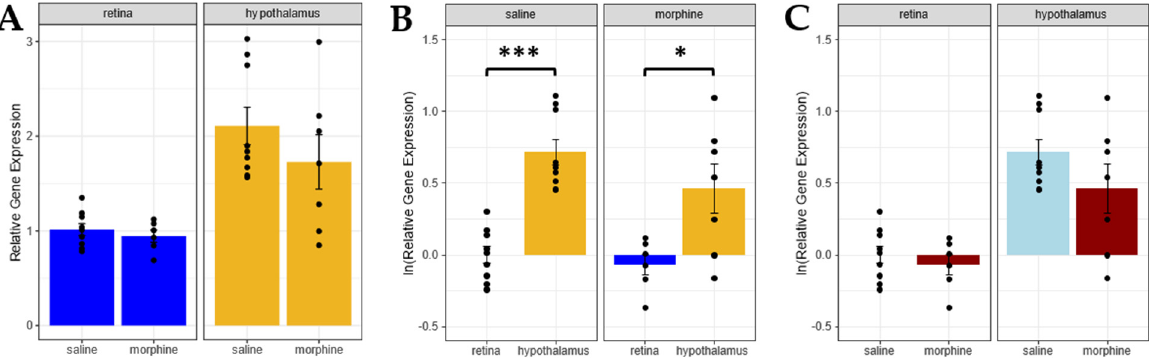
Figure 5. Reduced P-gp expression in the retina may underlie retinal morphine accumulation. P-pg mRNA expression ( A ) and natural logarithm (ln) ( B ) of P-gp mRNA expression is lower in the retina than in the hypothalamus at one hour (ZT 1) after an i.p. morphine injection at ZT 0. ( C ) Chronic morphine exposure does not affect P-gp mRNA expression in either tissue depositions at ZT 1. Two- way ANOVA with a Tukey post hoc adjustment was performed on an ln scale. Data are presented as the mean ± SD (* = p < 0.01, *** = p < 0.0001).